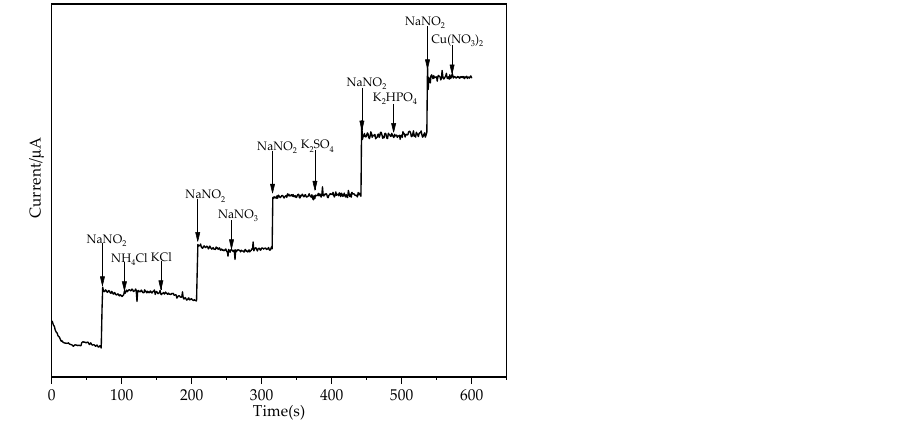
Figure 8. Typical amperometric current responses at AuNPs/MXene/ERGO/GCE for addition of 50 KCl, 500 μ M Cu(NO 3 ) 2 . Applied potential: 0.83 V.